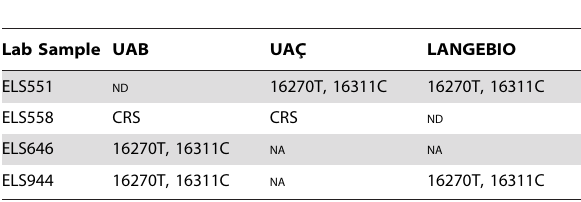
Table 1. Partial mitochondrial DNA sequences (16210–16319) obtained from the analyzed specimens in the different laboratories involved in the study.